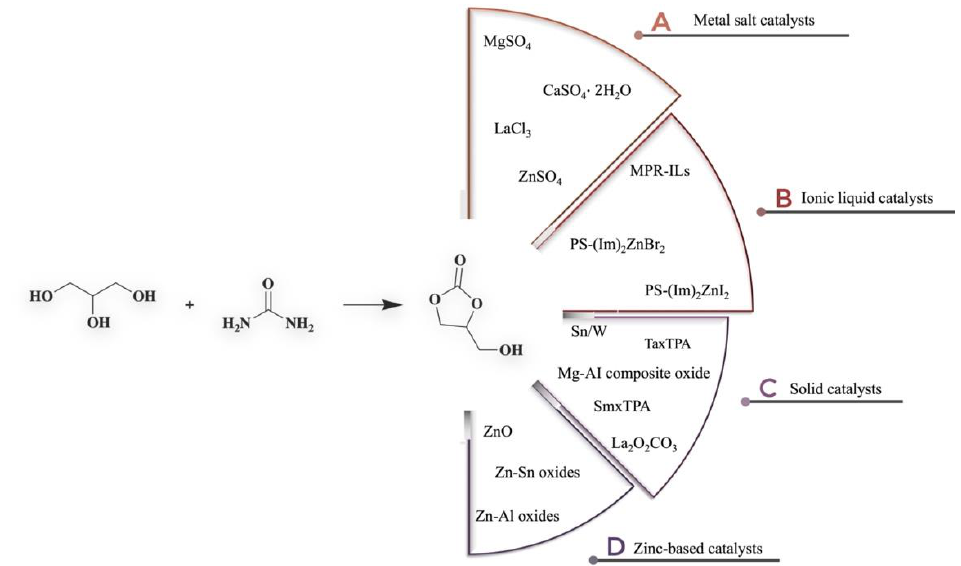
Figure 3 . Main categories of catalysts in GC synthesis through urea route .